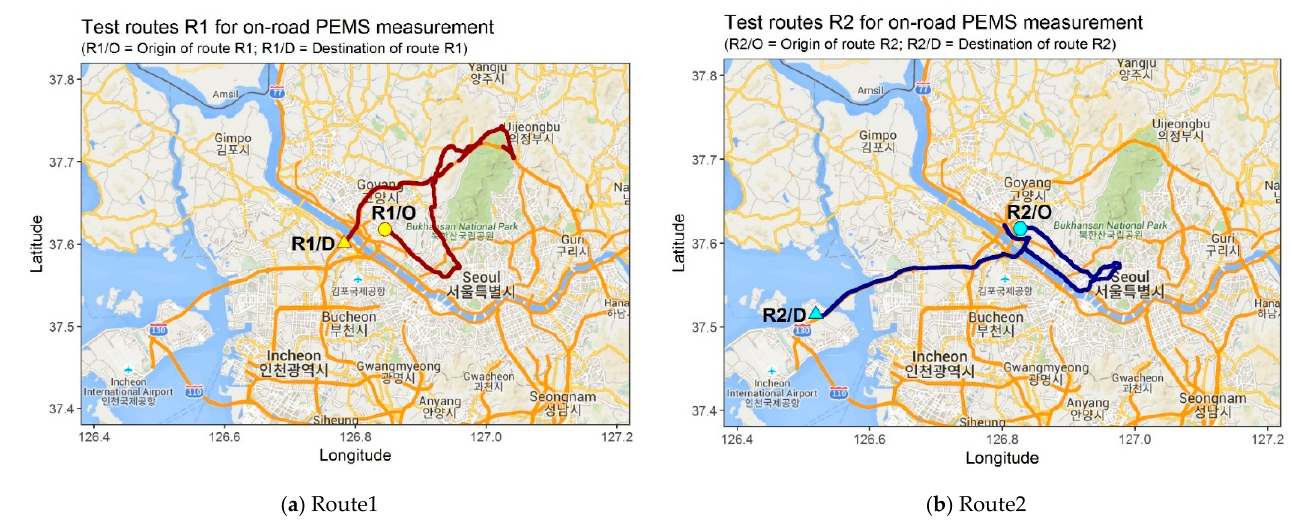
Figure 3. Routes for on-road emission tests.